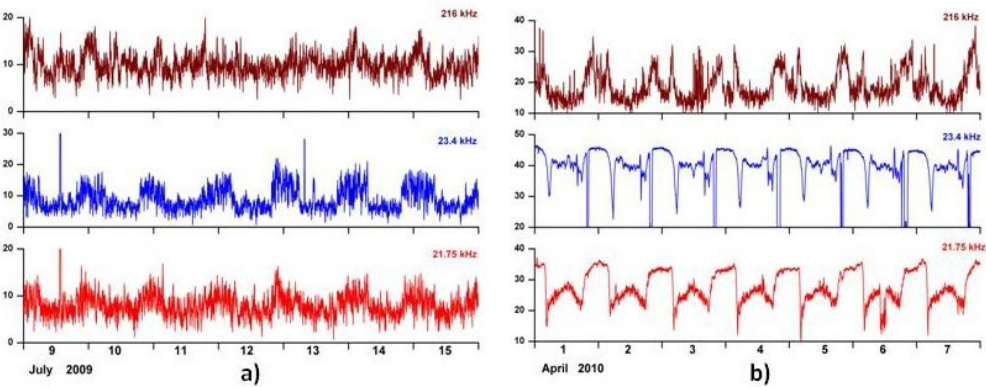
Fig. 5. (a) Trend of the intensity of VLF/LF radio signals sampled during seven days in Dobruja Observatory (Romania) using the rectilinear electric antennae. All the signals appear disturbed and irregular. (b) Trend of the intensity of the same radio signals sampled in the same place during seven days using the loop magnetic antennae. The reception of the different signals appears good enough and regular.